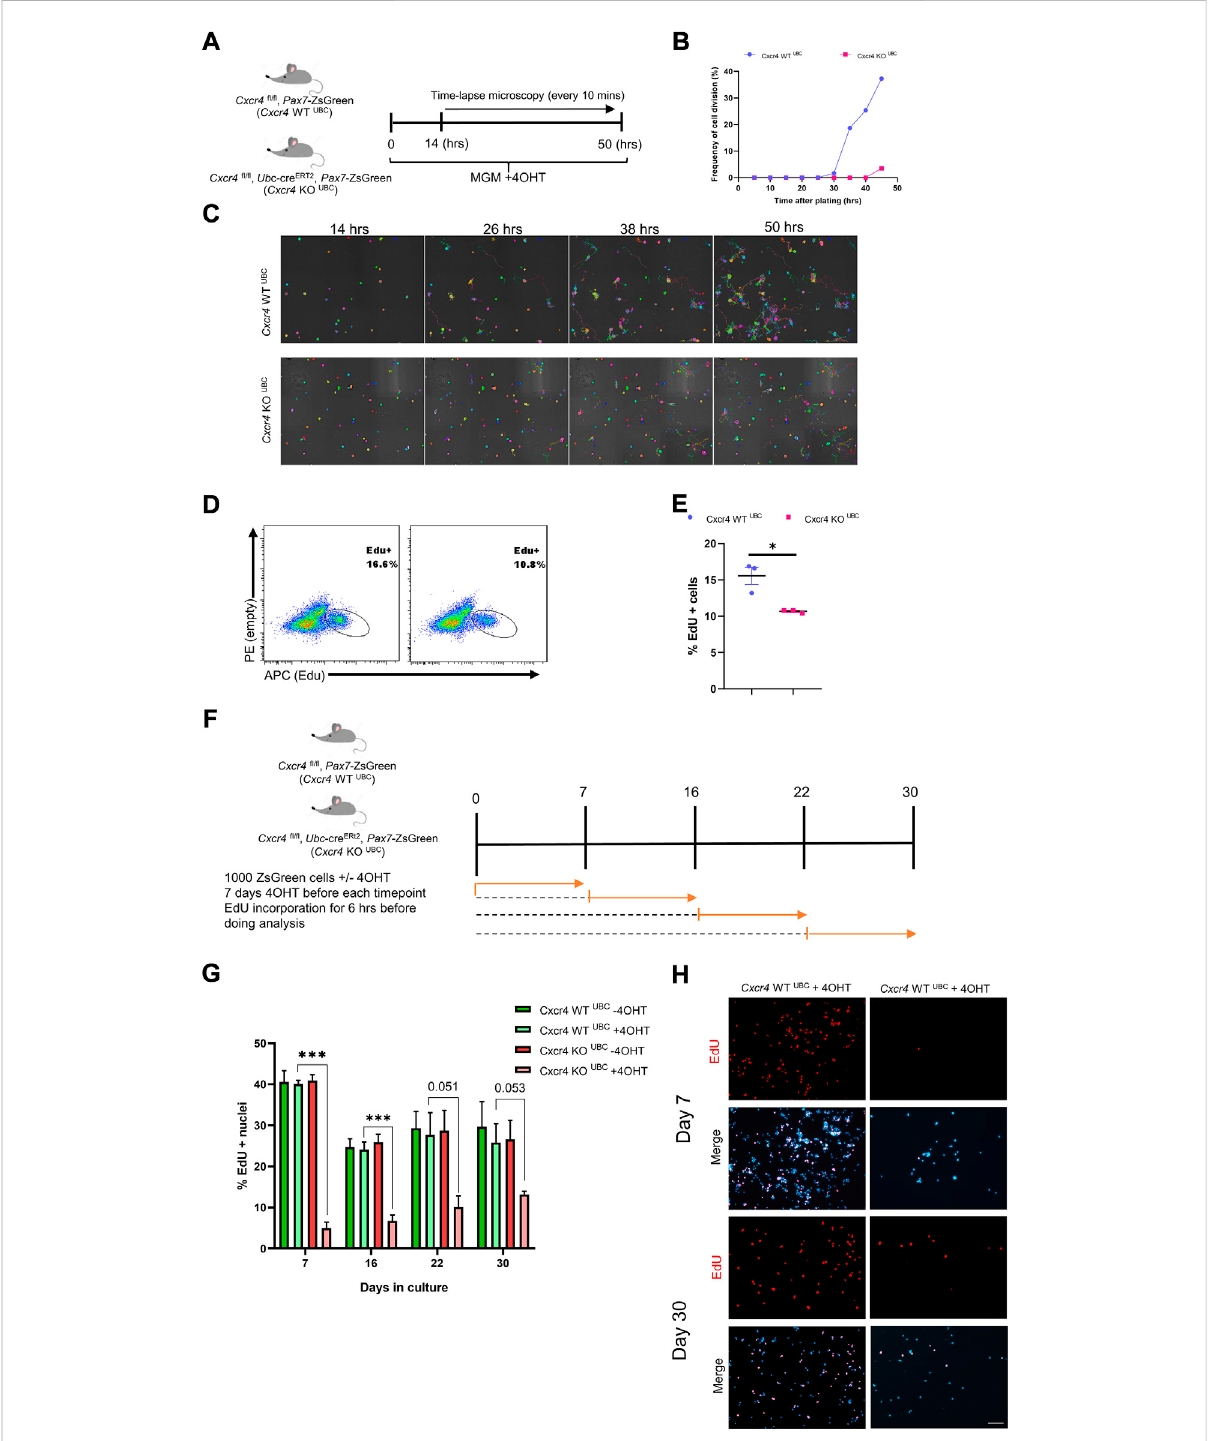
FIGURE 5 Differential dependence of satellite cells vs. established myoblasts on CXCR4. (A) Schematic for time lapse experiment measuring time to fi rst division. (B) Frequency of satellite cells having undertaken fi rst division over time. (C) Representative images tracing satellite cell mobility during time lapse imaging. Colors were randomly assigned by the Nikon Element software for every Binary Particle in the Time lapse movie. (D) Representative FACS plots for EdU staining of established myoblasts (6 weeks in culture) from Cxcr4-KO UBC ( n = 3) and Cxcr4-KO UBC ( n = 3) mice. Established myoblasts were treated with 4OHT for 1 week, and treated with EdU for the last 6 h of the fi nal day. (E) Quanti fi cation of EdU+ cells for the experiment shown in D. (F) Schematic for testing proliferation dependence on CXCR4 in cultured satellite cells over time. (G) Frequency of